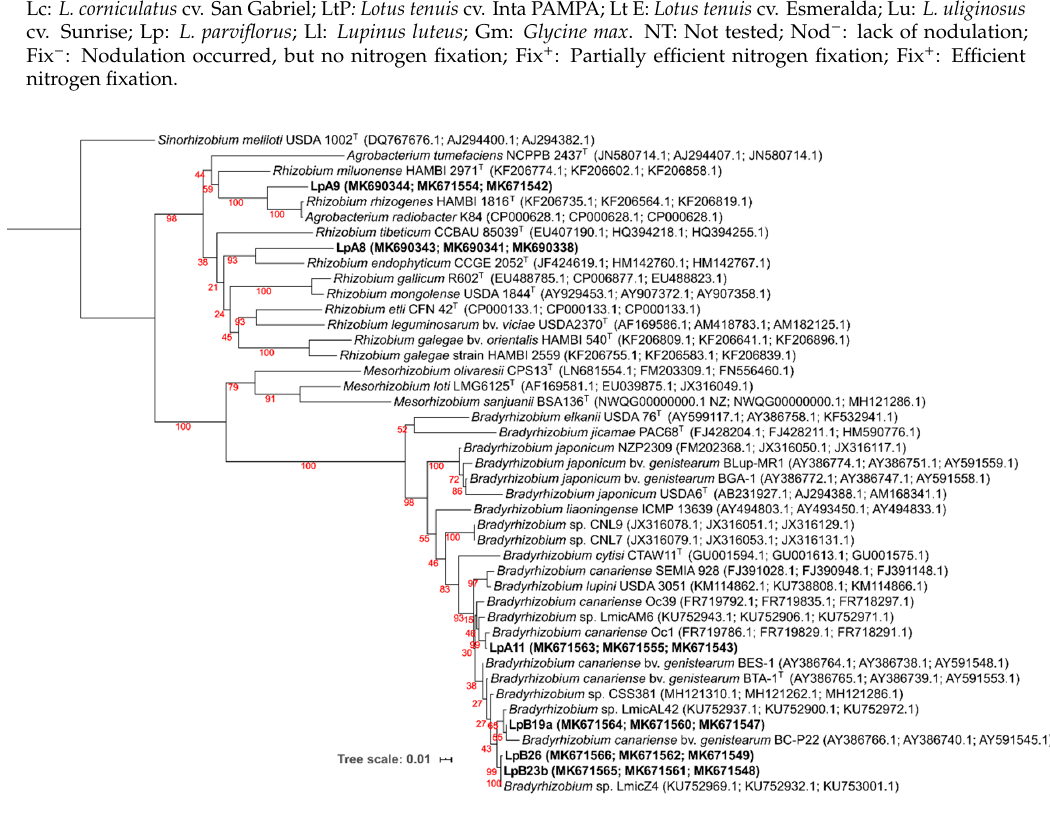
Figure 3. Phylogeny of concatenated sequences of gln II (300 nt), atp D (328 nt), and rec A (333 nt) genes, based on a total of 968 nt. Bootstrap values are shown in red at each node. Analyses were